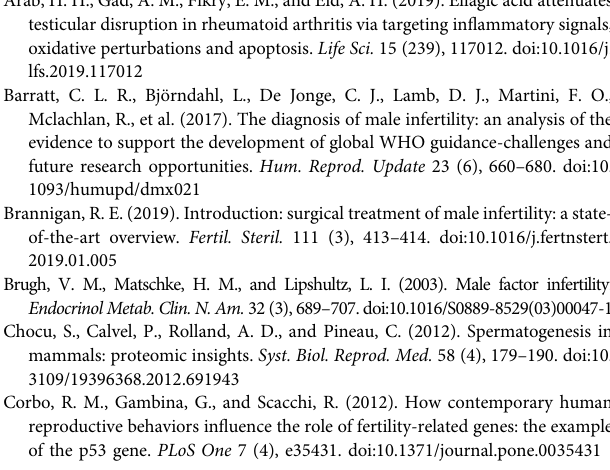
Frontiers in Pharmacology |